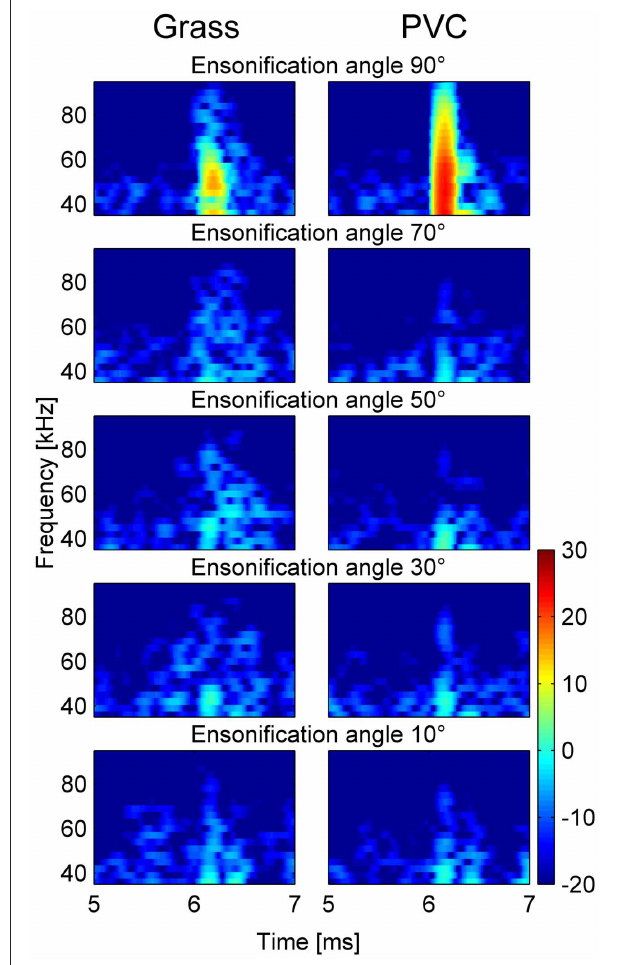
FIGURE 6 | Spectrograms of the impulse responses of the artificial grass and PVC surface at different ensonification angles. At an angle of 90 ◦ the impulse response of the PVC is stronger and smoother than that of grass (top row). At angles between 30 and 70 ◦ (second to fourth row) the impulse responses of the grass surfaces are longer and contain more high frequencies than those of the PVC surface. At 10 ◦ there is hardly any difference between the two